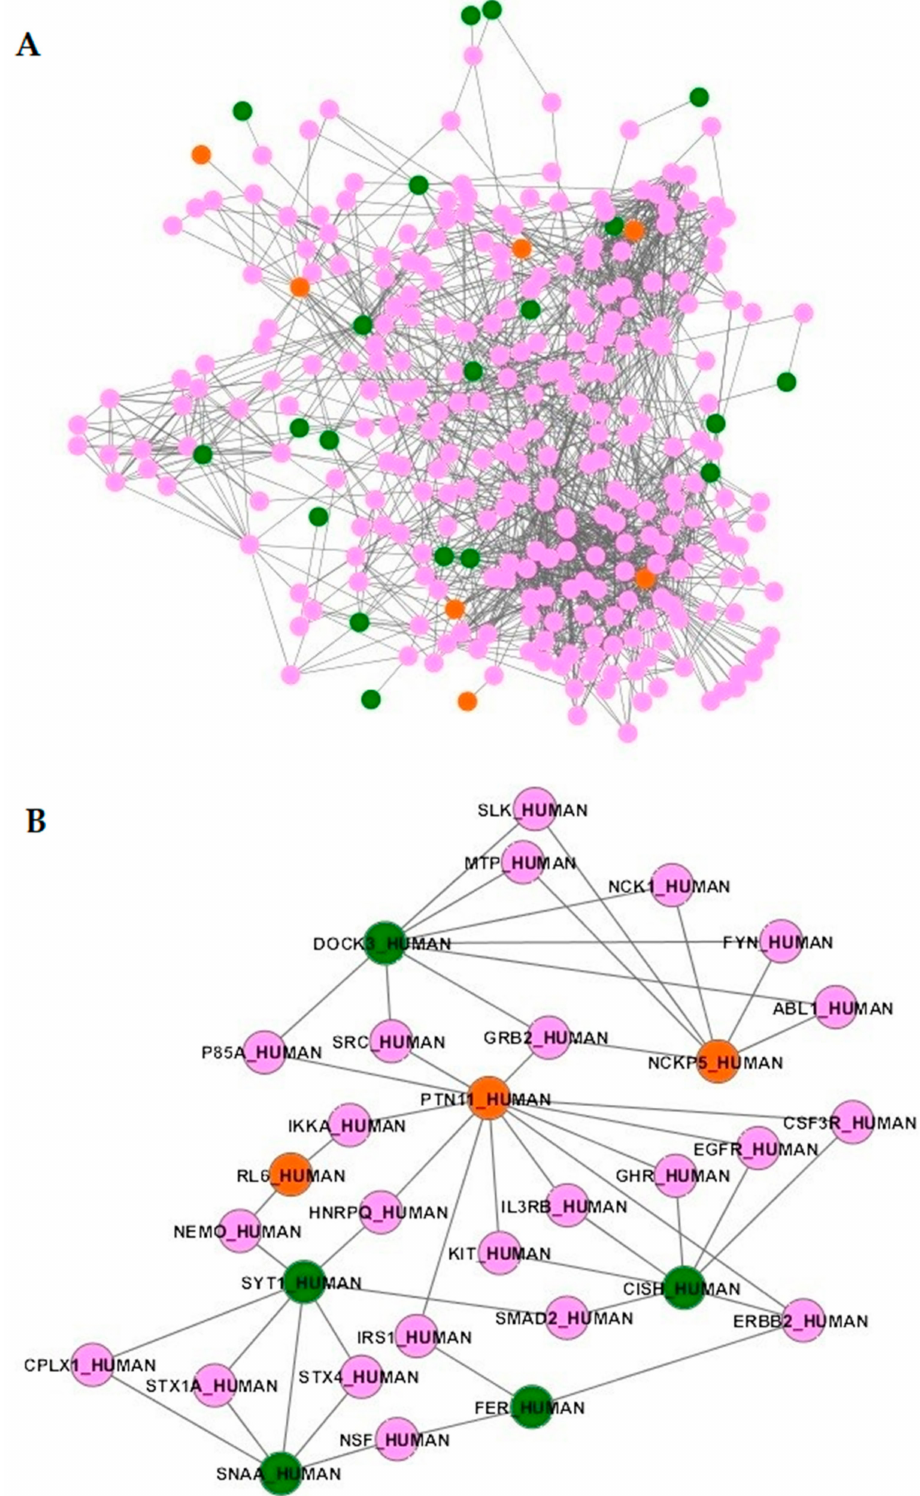
Figure 2. Subnetwork of the 27 connected proteins associated with sepsis and their direct interactors. Orange proteins are those encoded by genes associated with early mortality. Green proteins are those encoded by genes associated with late mortality. Pink proteins are direct interactors of proteins encoded by associated genes. The global network ( A ) and zooms on proteins of interest ( B ) are